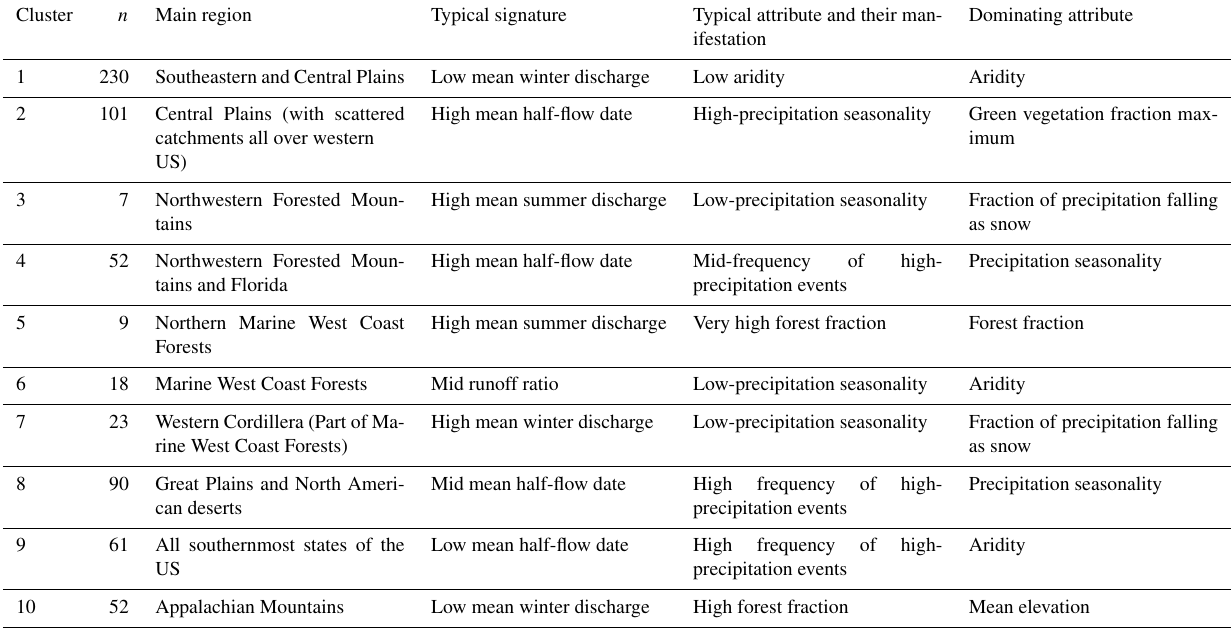
Table 2. Properties of the catchment clusters. Typical signatures and attributes refers to the signature and attribute of the cluster with the lower coefficient of variation scaled by the mean coefficient of variation of the whole dataset. Dominating attribute refers to the catchment attribute that has the highest weighted R 2